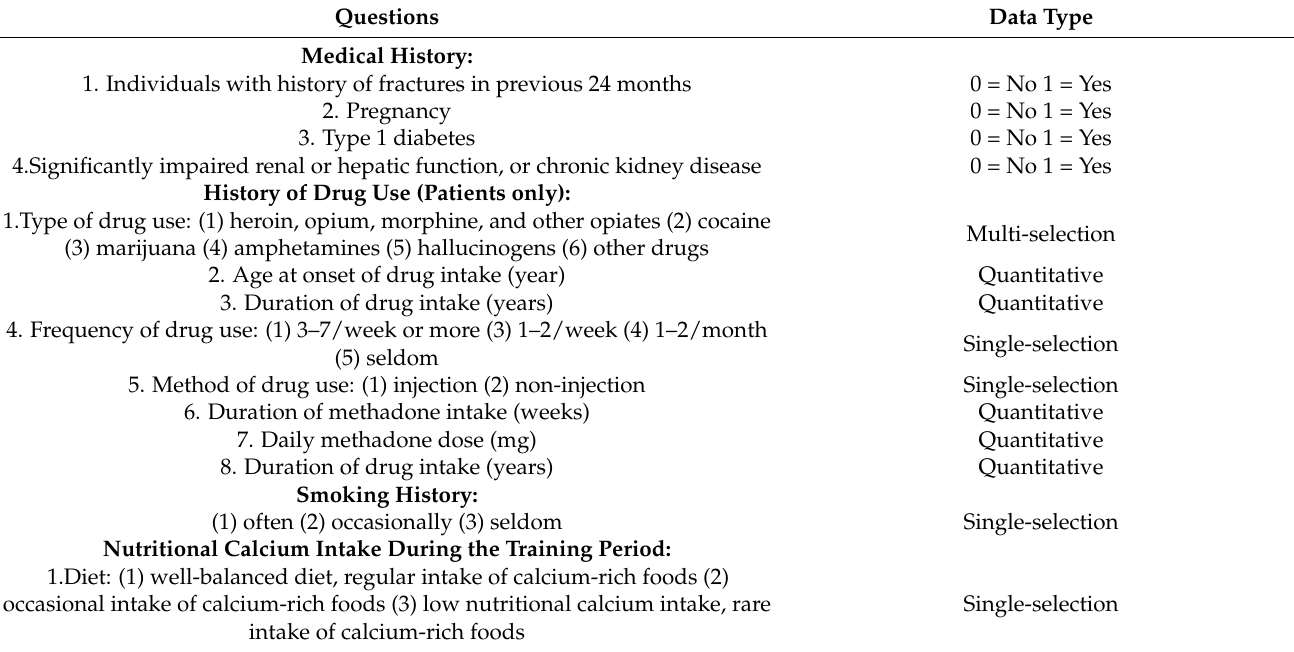
Table 1. Questionnaires for the low bone quality intervention experimental group and low bone quality observation control